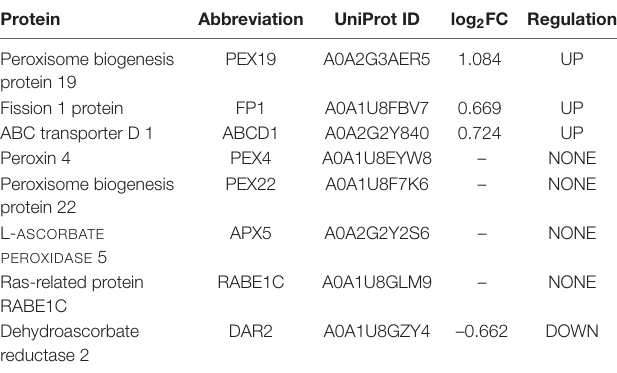
TABLE 3 | Peroxisomal membrane-associated proteins (PMPs) which are differentially expressed during sweet pepper fruit